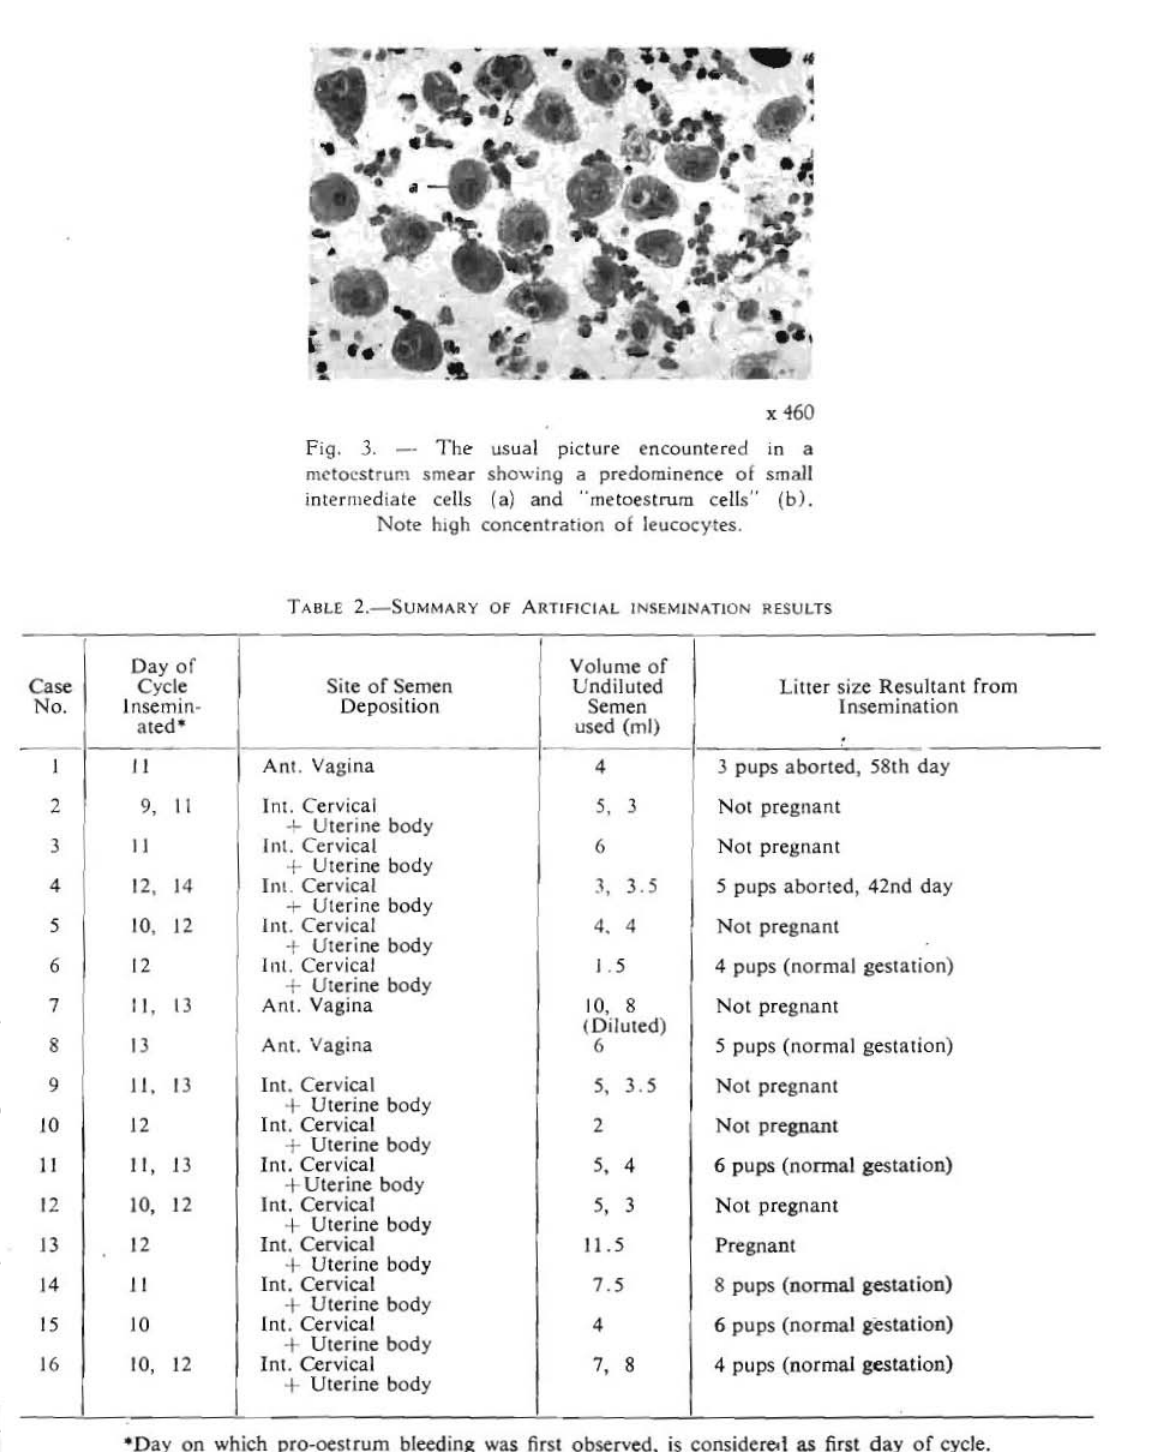
The usual picture encountered 10 a melOcStrurl smear showing a predomintnce of small intermediate cells (a) and "metoestrum cells" (b). Note high conCenlralton of